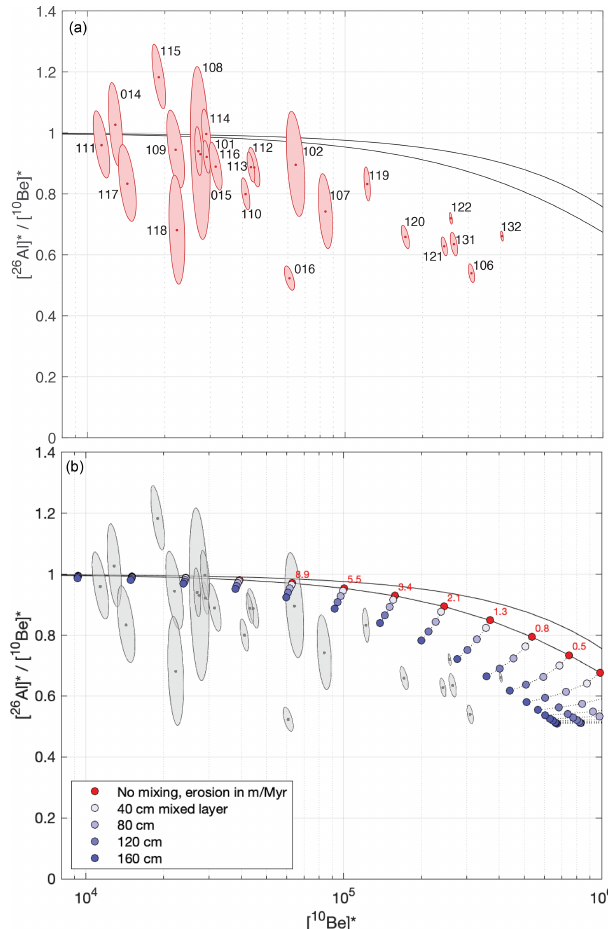
Figure 5. 26 Al / 10 Be two-isotope plots. To permit comparison of data from different locations and elevations on the same plot, nu- clide concentrations have been normalized by dividing measured concentrations by calculated mean production rates in the respective drainage basins using production rate calculations from version 3 of the online exposure age calculator described by Balco et al. (2008) and subsequently updated. In both plots, uncertainty ellipses denote 68% confidence regions for the normalized nuclide concentrations, and the black lines are the boundaries of the simple exposure re- gion (Lal, 1991) calculated using the conventional assumption of steady block erosion without vertical mixing. Panel (a) shows that 26 Al / 10 Be ratios from basins with high nuclide concentrations, im- plying low erosion rates, are systematically lower than predicted by steady erosion without vertical mixing. Panel (b) shows that this in- consistency can, at least in part, be explained by the presence of a mixed layer of at least 160cm. Circles show expected steady- state nuclide concentrations in a fully mixed surface layer calcu- lated according to Lal and Chen (2005) for a range of erosion rates and mixed layer thicknesses, which highlights that sediment derived from a deep mixed layer has lower nuclide concentrations and lower 26 Al / 10 Be ratios than would be expected if the mixed layer were absent. The sample ID is as in panel (a)